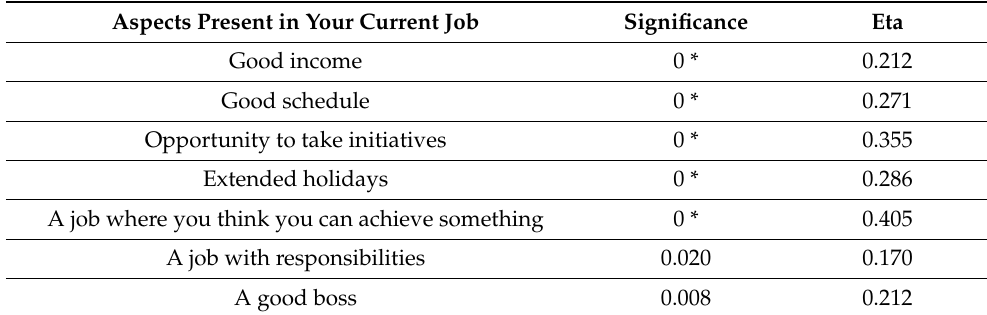
Table 4. SEWBI and current research job situation.